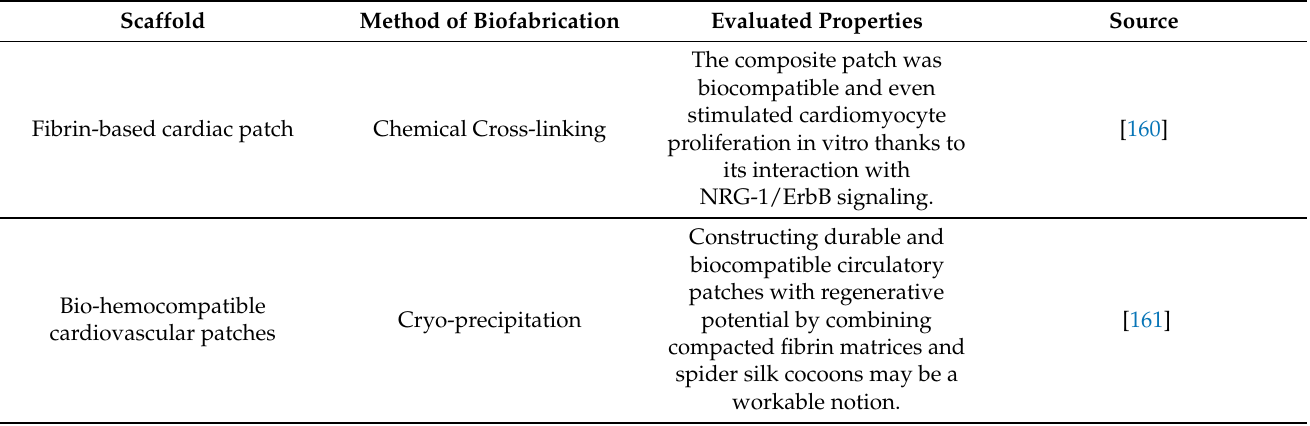
Table 3. Fibrin-based scaffolds for heart tissue engineering.